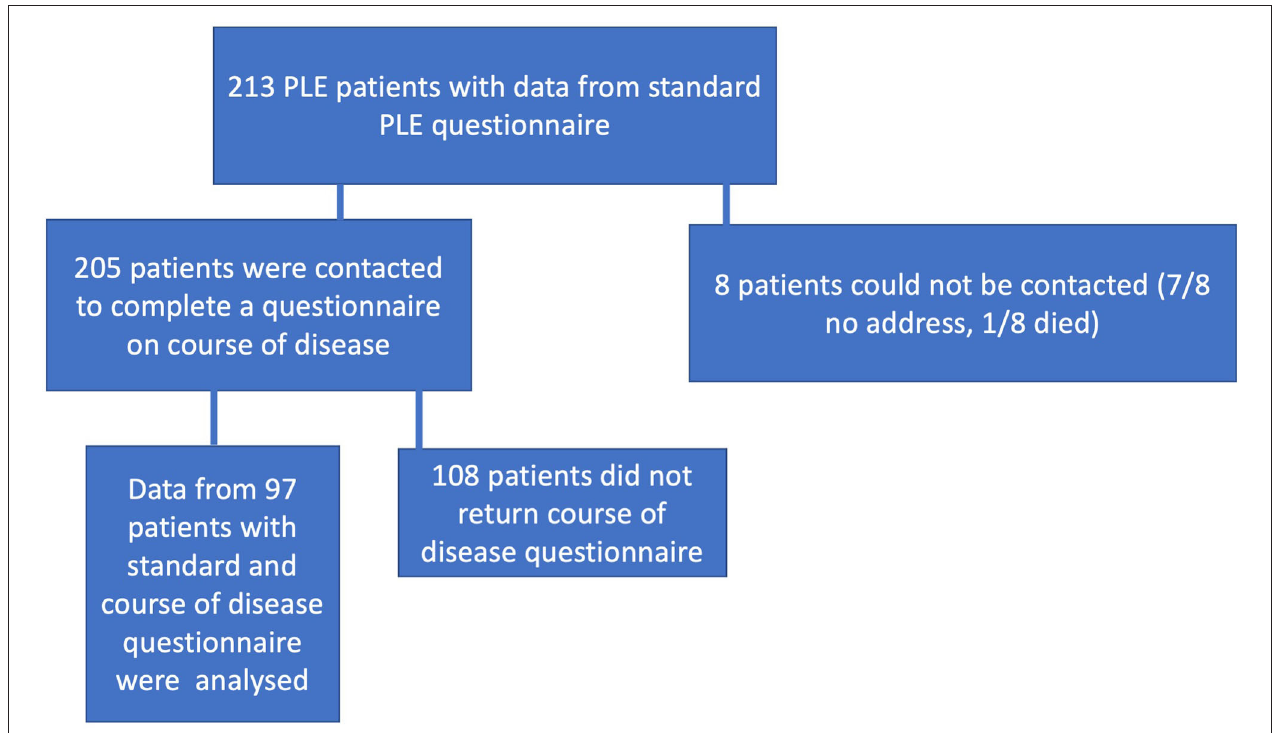
FIGURE 1 | Patient flow